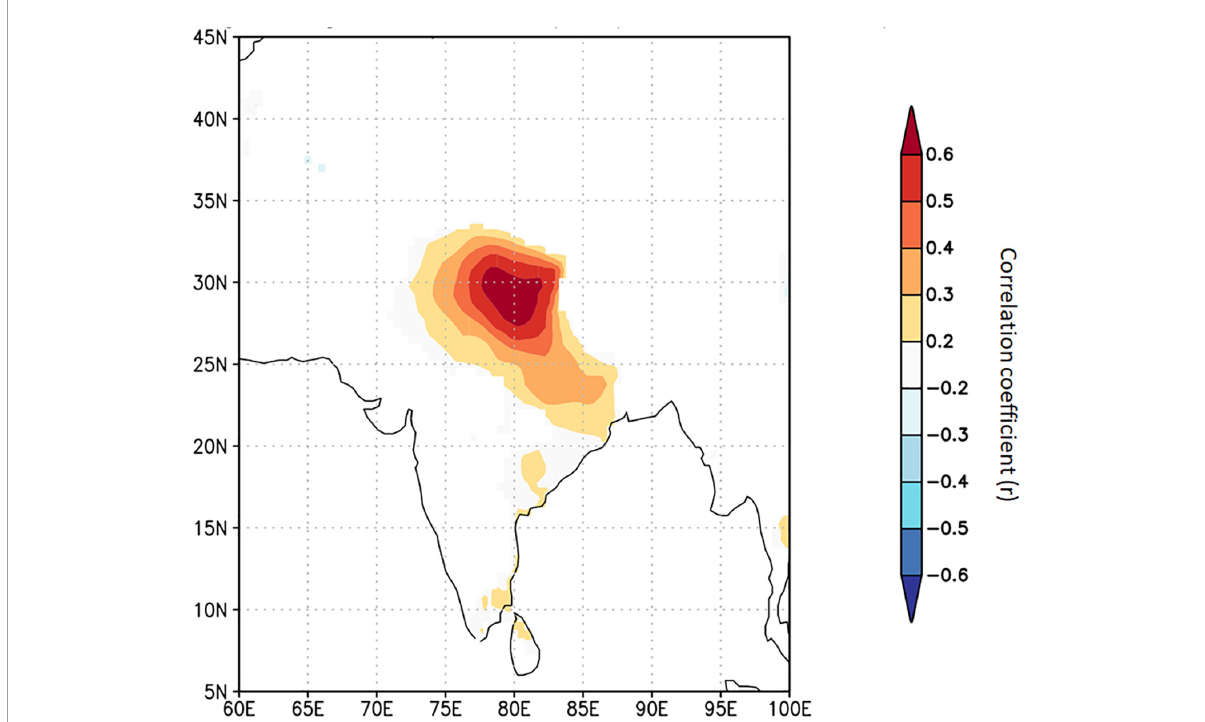
FIGURE6 Spatial correlation of the reconstructed PPT JJA with gridded CRU JJA precipitation during the period